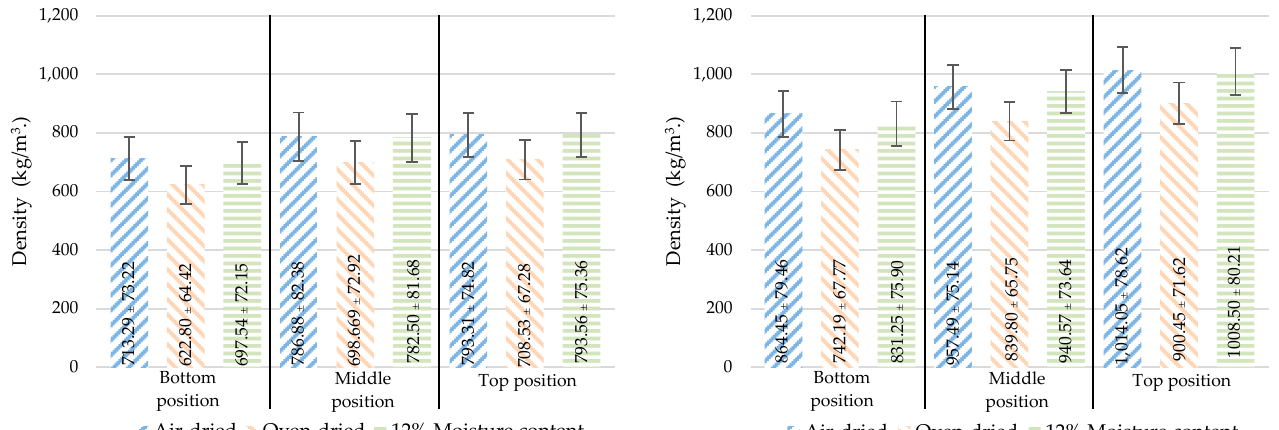
Figure 7. The density varied with moisture content and position: ( a ) internode, ( b ) node (mean ± standard deviation).